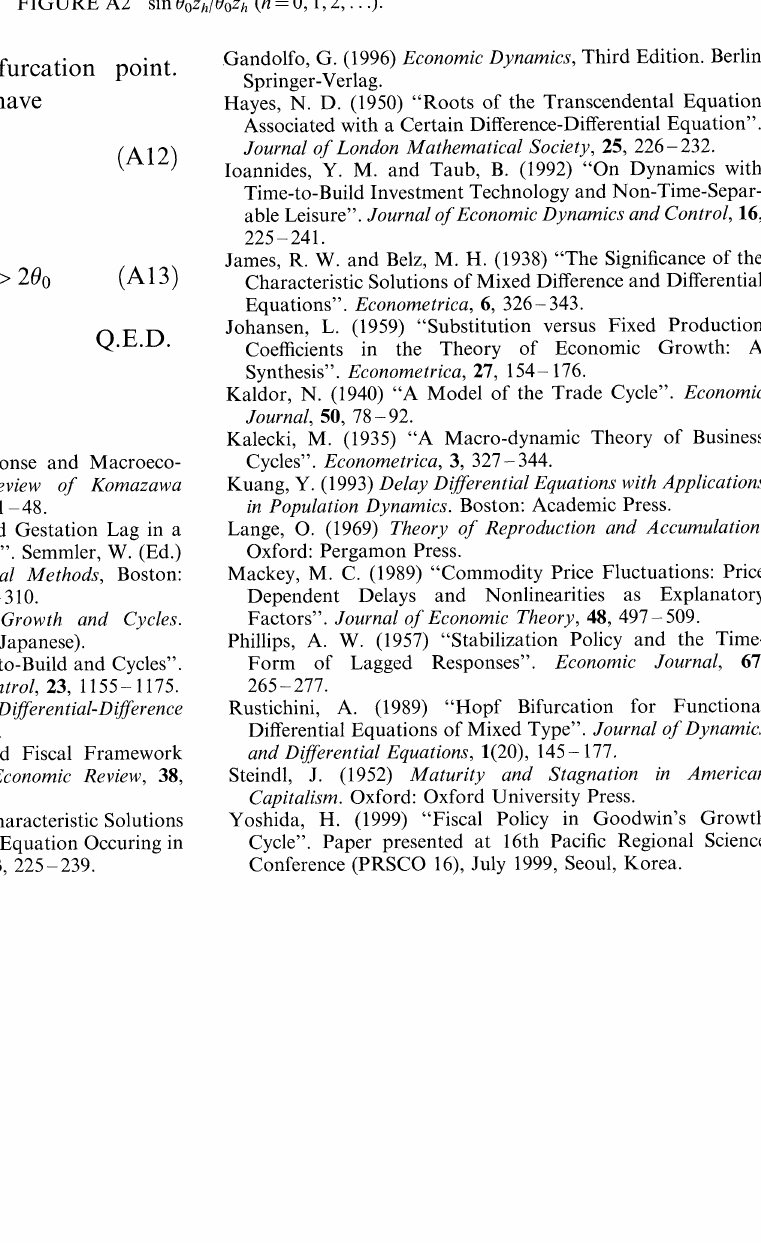
FIGURE A2 sin Oozh/Oozh (h 0, 1,2